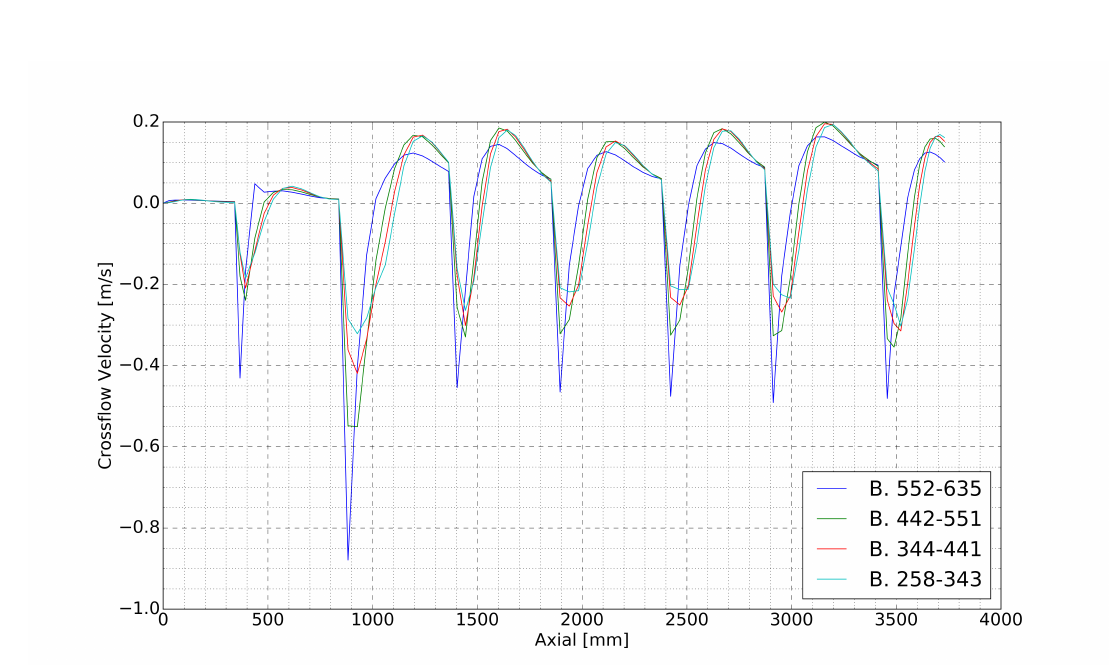
Figure 6. Example of crossflow velocity - variant 1.